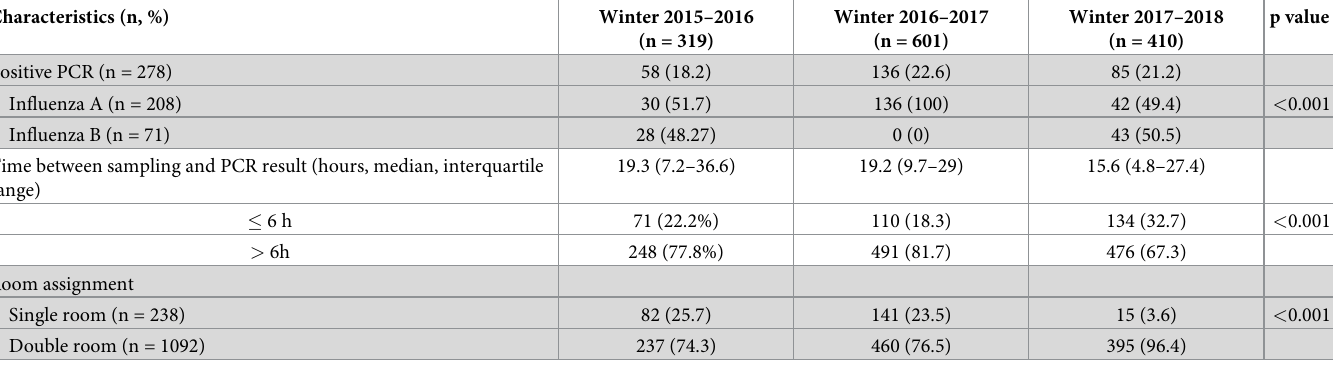
Table 2. Summary of PCR results and room assignment for patients with ILI during the three winter epidemics (2015–2018), at Bichat Claude Bernard Hospital. Characteristics (n,